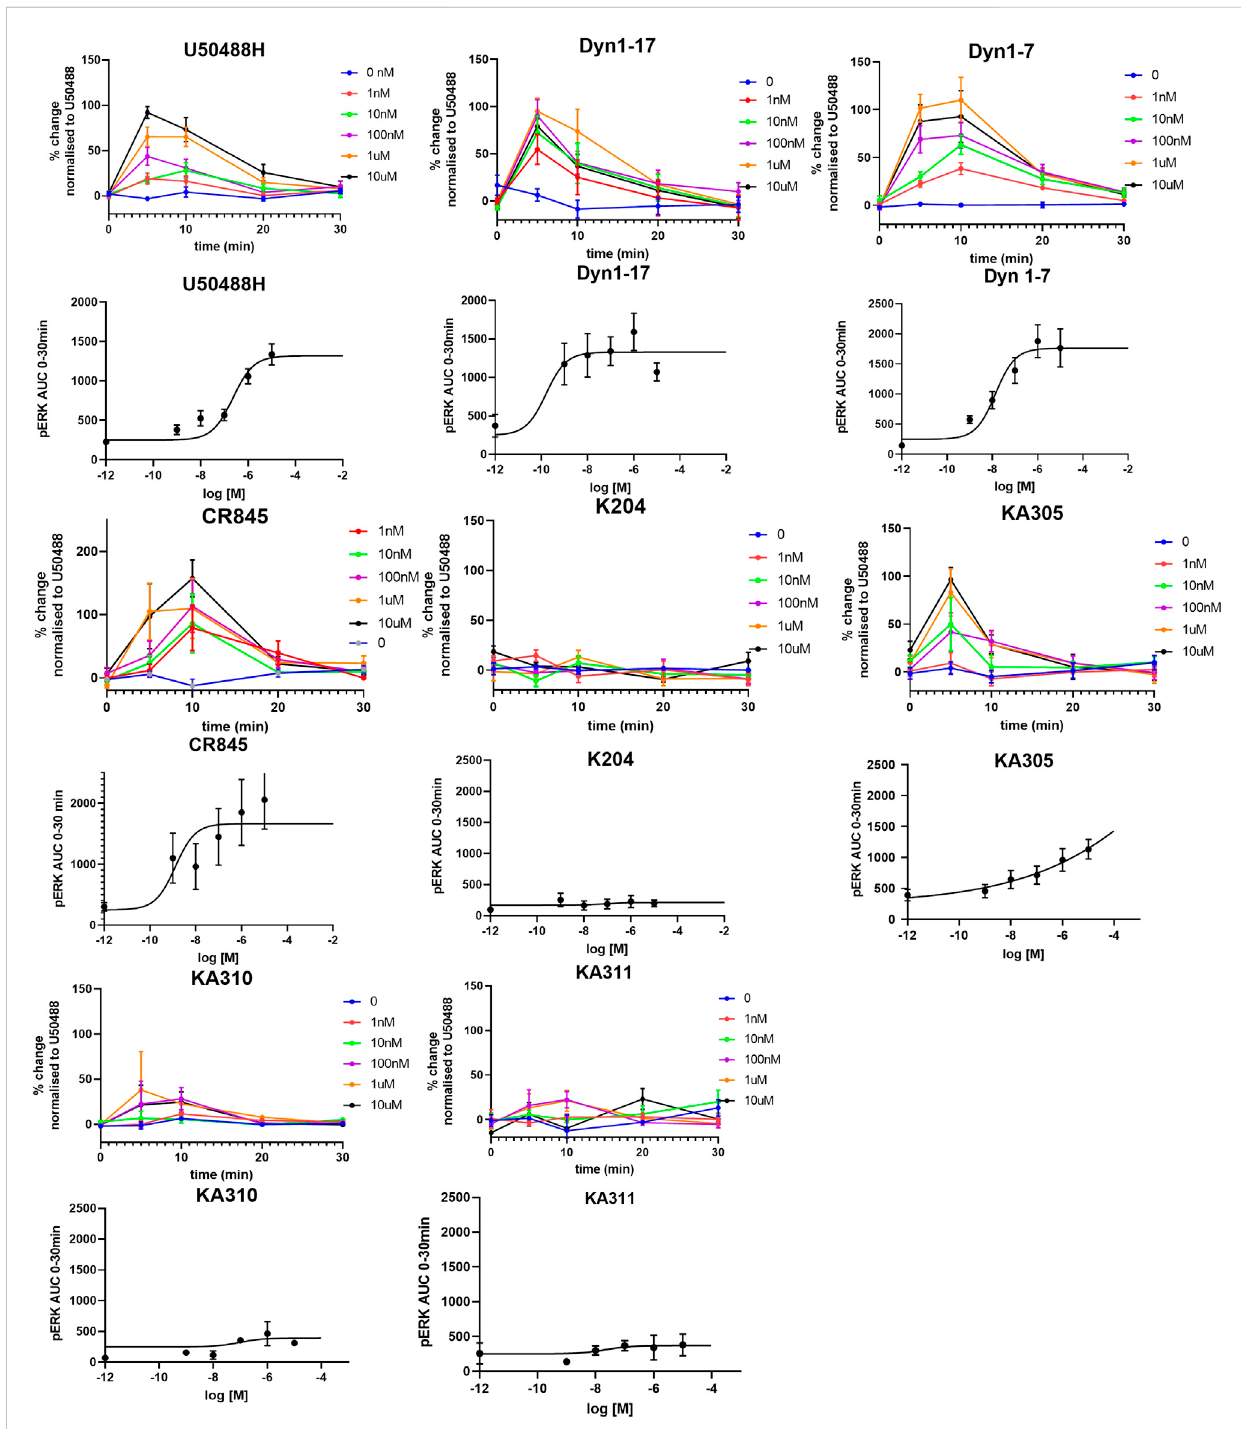
FIGURE 7 Expression of pERK 1/2 in response to agonists in HEK293-KOP cells. For each agonist, graphs of concentration over time are plotted, from which AUCwascalculatedandplotted againstconcentrationfordeterminationofEC 50 (sigmoidalcurves).Clearly,KA204,KA310,andKA311displayednopERK activation. Data shown are means ± SEM; n = 3 in triplicate per data